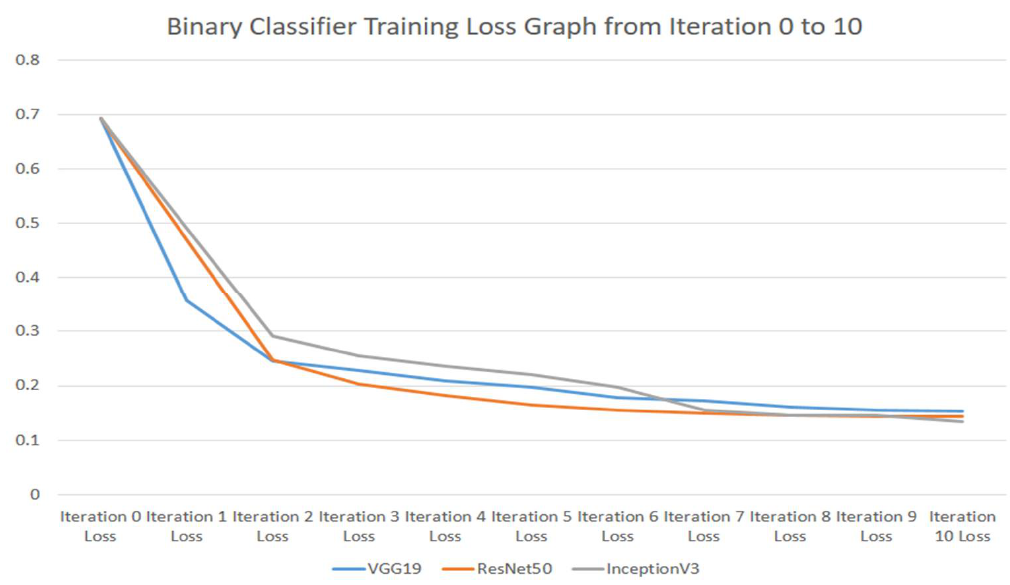
Figure 5. Binary classifier training-loss graph from iteration 0 to 10 for VGG19, ResNet50, and InceptionV3 Models. The three-class classifier training-loss graph from iteration 0 to 10 for VGG19, ResNet50, and InceptionV3 is shown in Figure